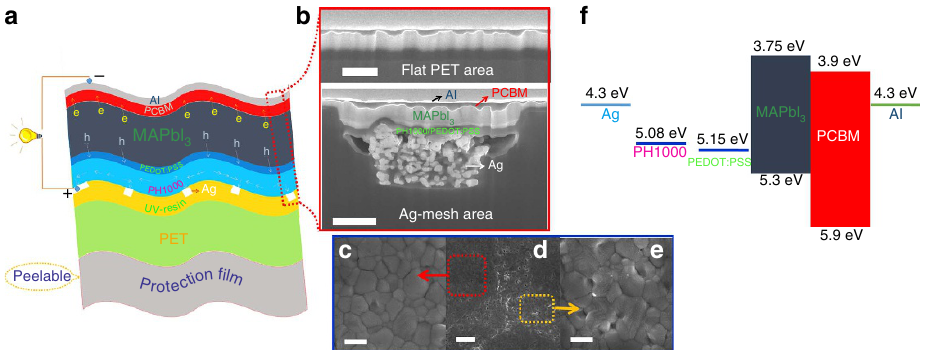
Figure 2 | Flexible pero-SCs architecture and morphology. ( a ) Device architecture of the hybrid electrode/PEDOT:PSS (35nm)/MAPbI 3 ( B 280nm)/ PCBM ( B 60nm)/Al (100nm) cells tested in this study. ( b ) Cross-section SEM images of complete perovskite devices showed both Ag-mesh area (scale bar, 1 m m) and Flat PETarea (scale bar, 500nm). SEM top-view images of perovskite films; ( d ) : low-resolution image of perovskite film coated on both flat PET and Ag-mesh (scale bar, 2 m m); ( c ): film surface on bare PET (scale bar, 500nm); ( e ): film surface on Ag-mesh (scale bar, 500nm). ( f ) The corresponding energy-level diagram of each layer.